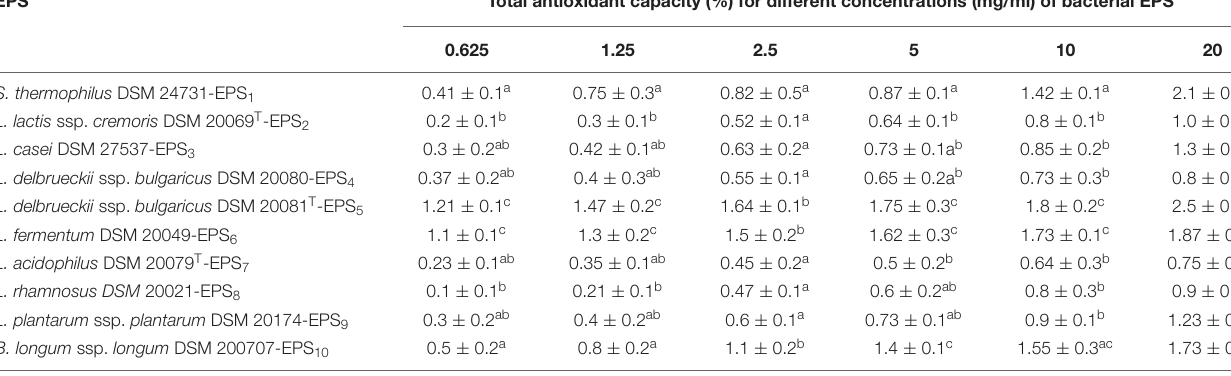
TABLE 3 | Antioxidant activities (%) of EPS derived from LAB and Bb using total antioxidant capacity (TAC) scavenging